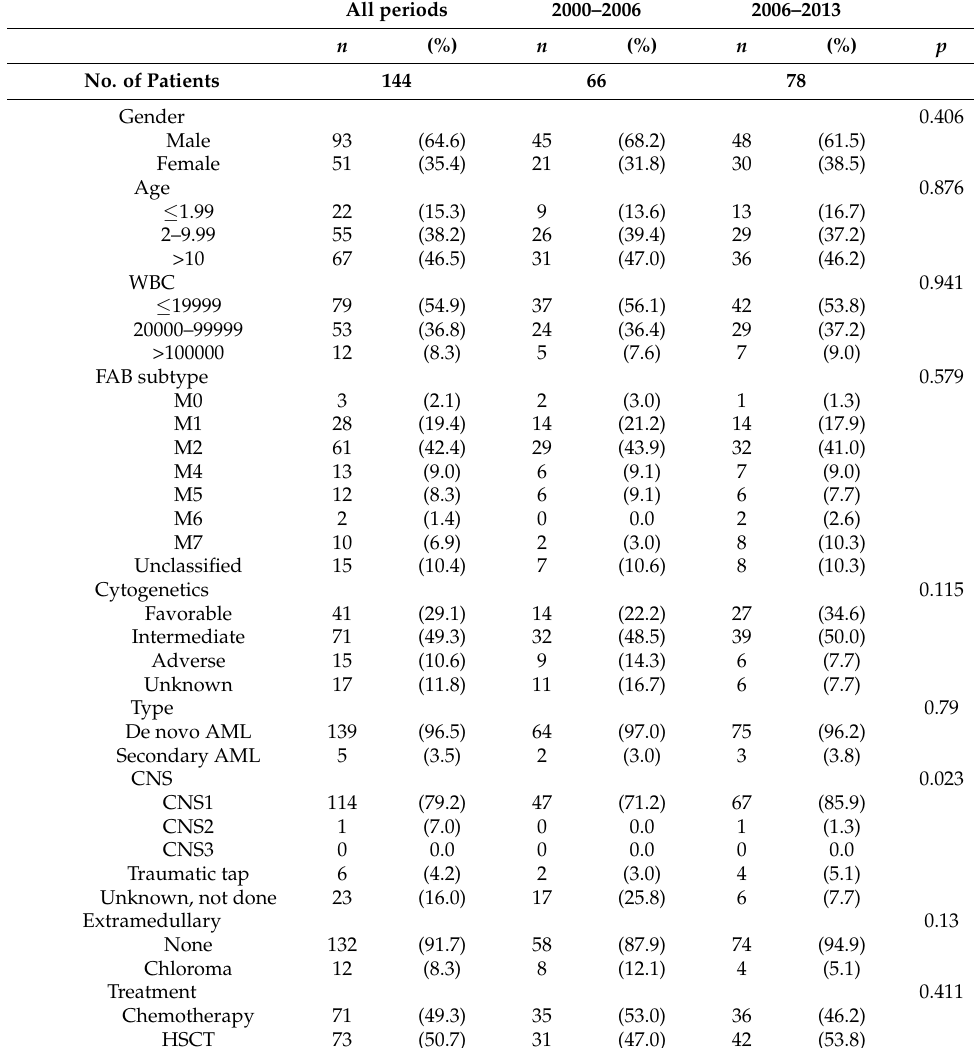
Table 1. Baseline characteristics of